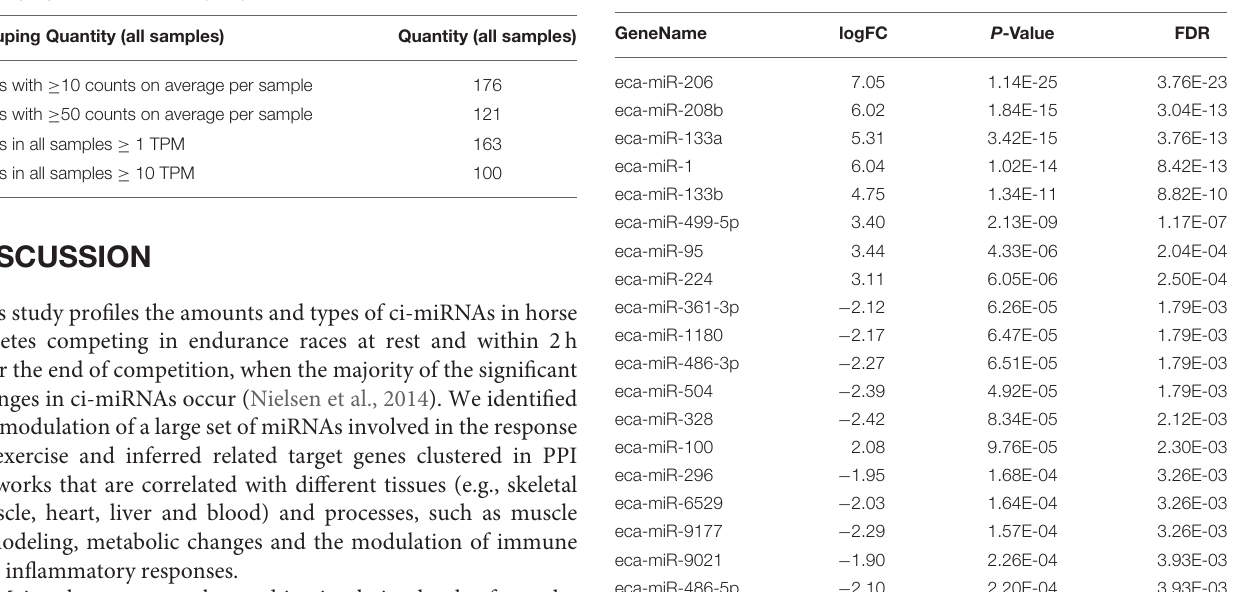
TABLE 4 | The 20 most significantly differentially expressed microRNA between T0 and